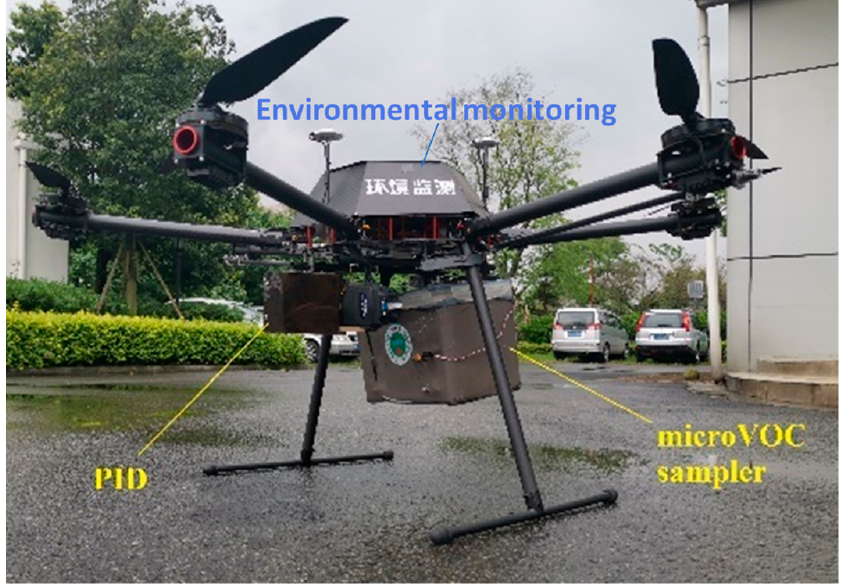
Figure 1. The environmental monitoring UAV with attached PID and microVOC sampler.